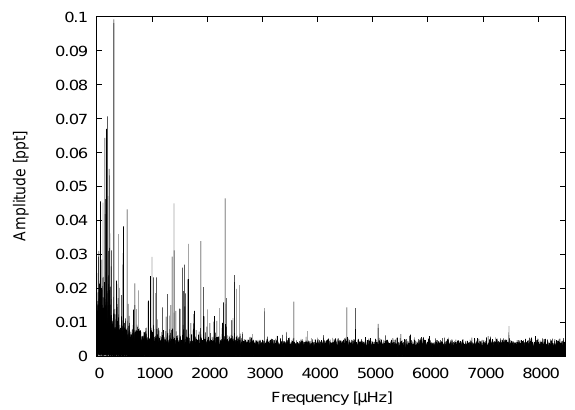
Figure 1. The amplitude spectrum of HWVir observed during K2 mission Campaign10.